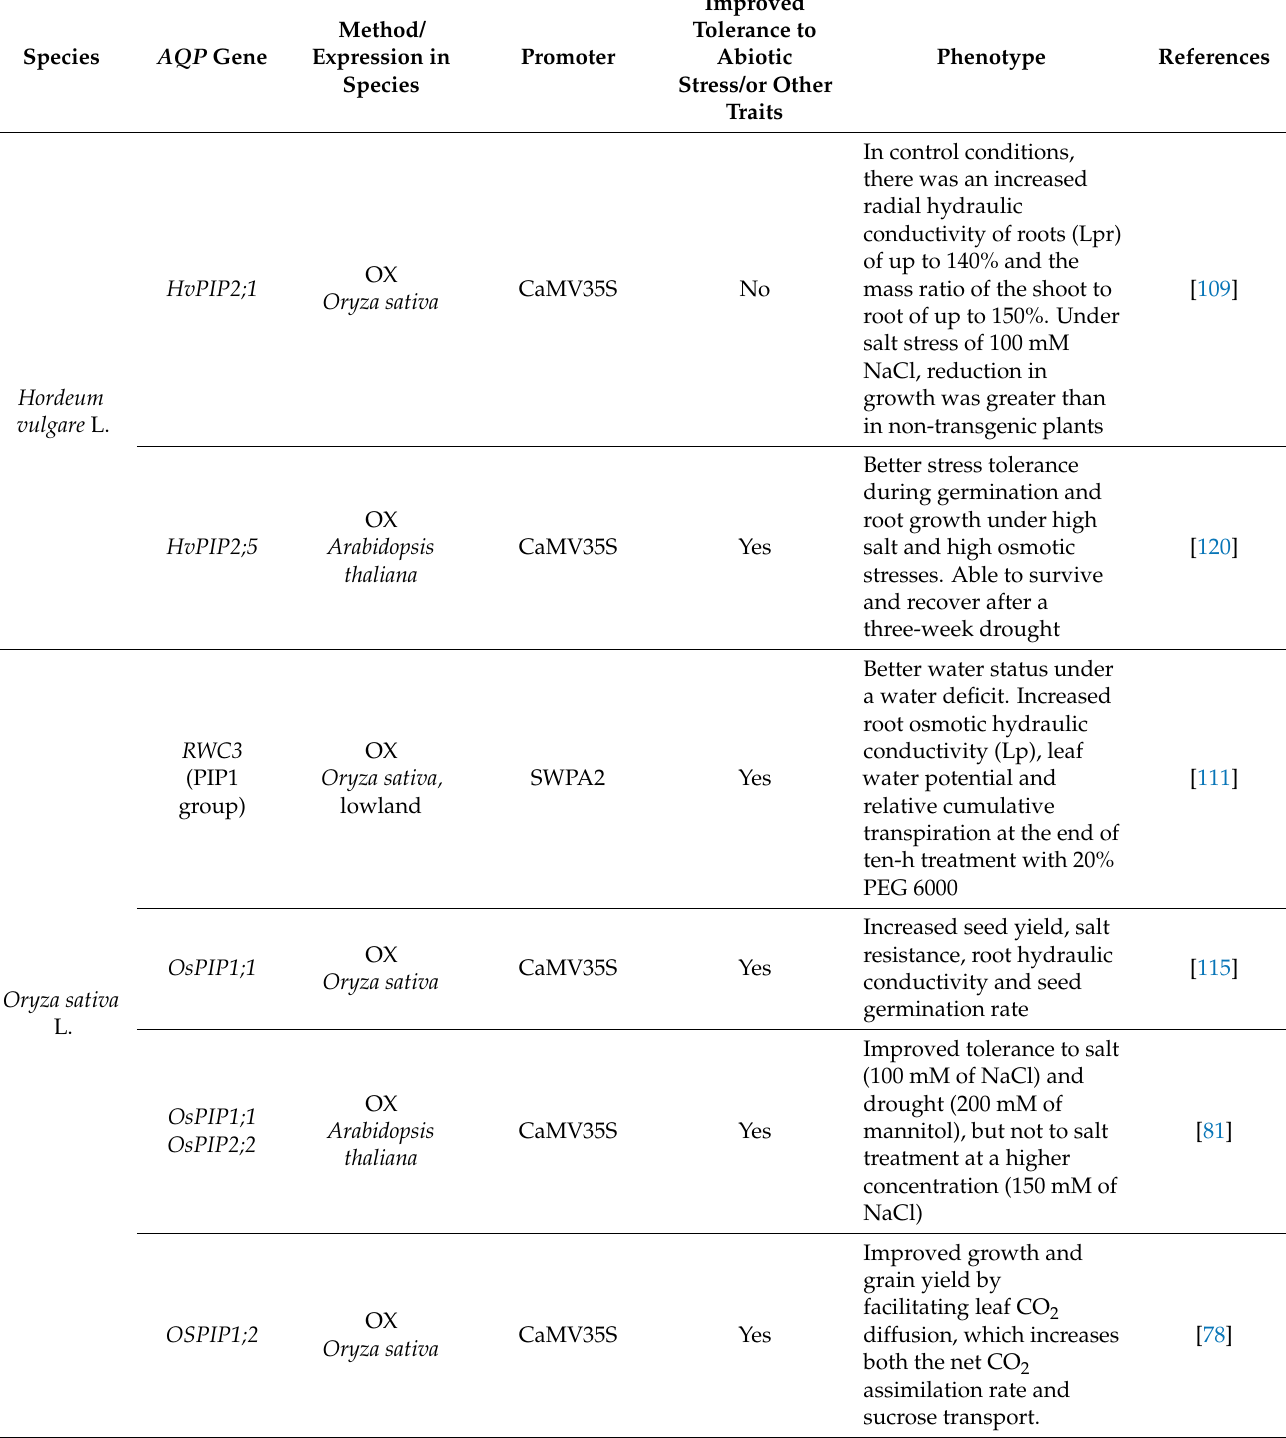
Table 3. Genetic manipulation of the AQP genes of cereals and its effect on the plant phenotype.